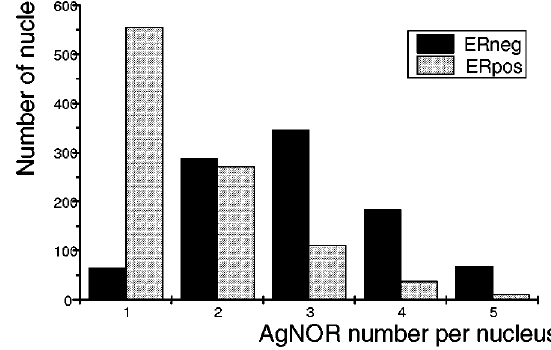
Fig. 2. Relative number of cells containing n AgNORs ( n = 1, ::: ,5) in ER-negative and ER-positive